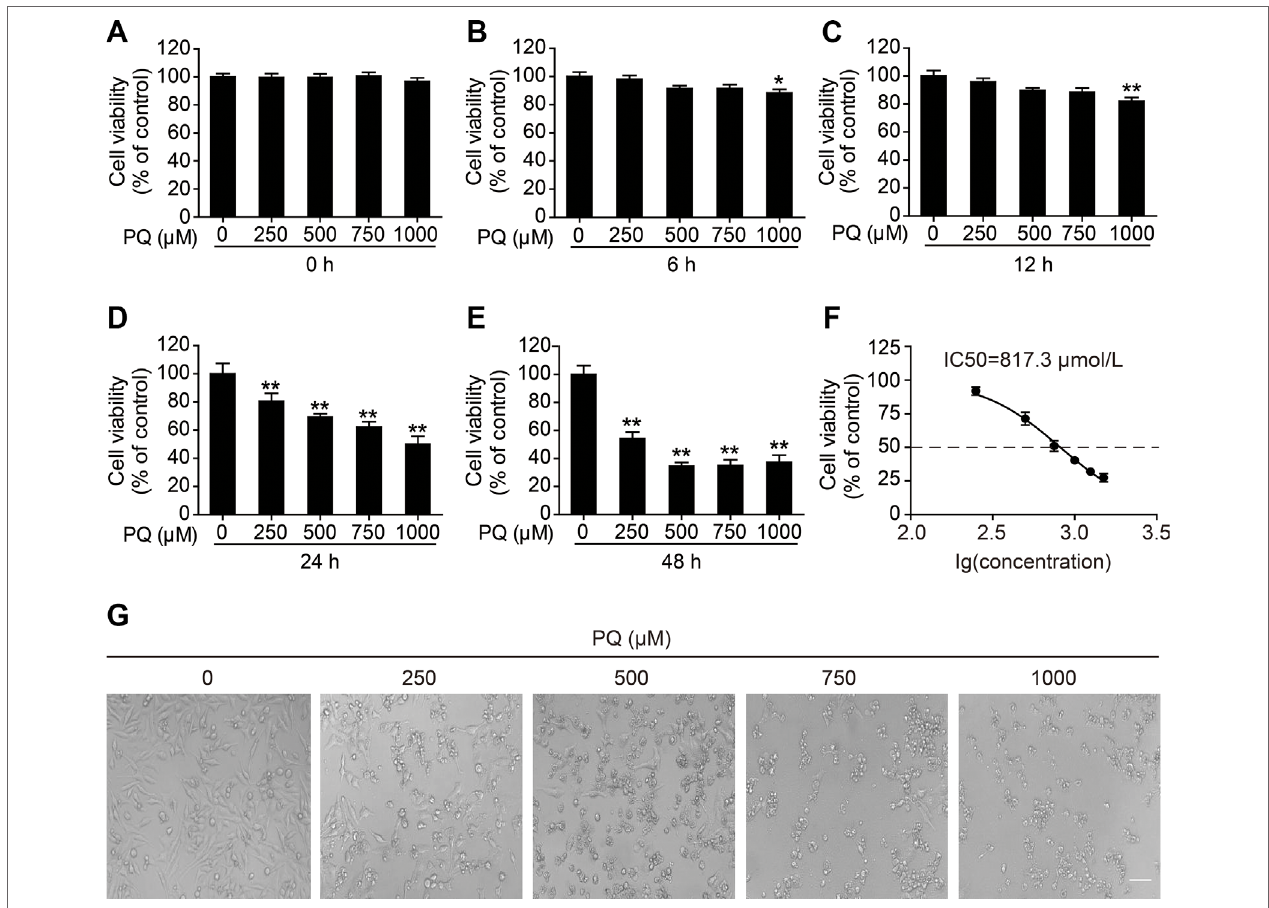
FIgURe 1 | Dose- and time-dependent cytotoxicity of PQ in L02 cells. Cell viability was measured by a cell counting kit (CCK)-8 assay (A) 0, (B) 6, (C) 12, (D) 24, and (e) 48 h after treatment with the indicated concentrations of PQ. (F) The mean inhibitory concentration (IC50) fit curve was calculated according to PQ exposure for 24 h and the measurement of the inhibition of cell viability. The values are presented as the means ± SEM ( n = 8). * p < 0.05, ** p < 0.01 vs control group. (g) Morphological observation of PQ-induced cell damage detected by light microscopy. Scale bar: 80 μm.